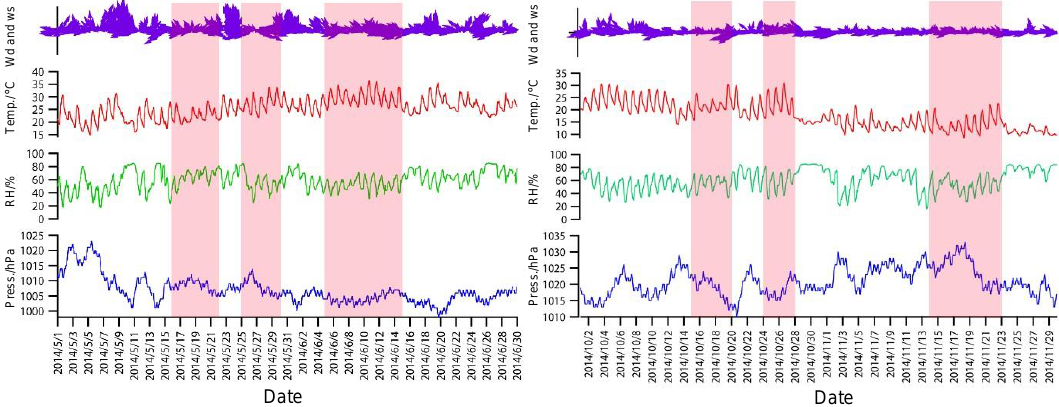
Figure 7. Meteorological patterns in Wuhan during the monitoring period. Pink shaded areas represent PM 2 . 5